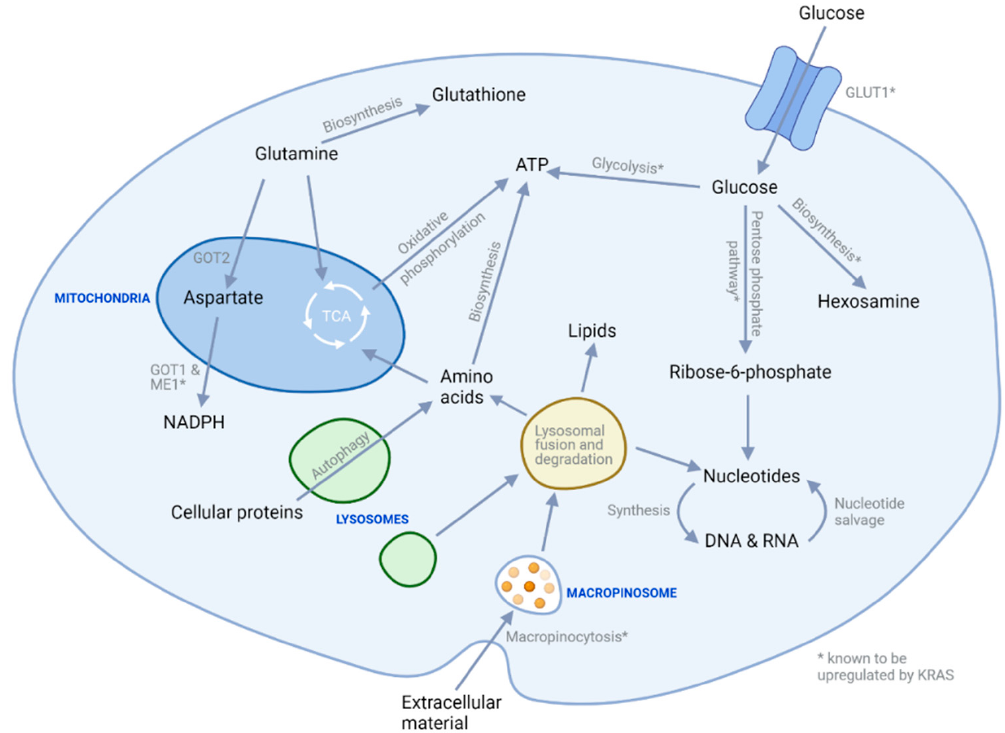
Figure 1. Key metabolic pathways in PDAC cells. Glucose, the intracellular abundance of which is increased by Kras- mediated GLUT1 upregulation, is a key metabolic and biosynthetic fuel usually oxidised in the mitochondria to produce ATP. However, while some mitochondrial oxidation of glucose does occur in cancer cells, proportionally higher levels are diverted from this pathway to be utilised in biosynthetic reactions to produce hexosamine (used in protein glycosylation) and ribose-6-phosphate (used in nucleotide synthesis). Cancer cells also show a greater dependency on glycolytic ATP generation with upregulation of this pathway in PDAC mediated both by oncogenic signalling via the Kras pathway and hypoxic conditions resulting from hypovascularity. Cancer cells also demonstrate an enhanced use of glutamine, which is vital in cellular proliferation due to its use in ATP generation and the production of NADPH and glutathione to maintain cellular redox balance. Nutrient deprivation in PDAC due to hypovascularity also alters cellular metabolism, evoking a requirement for alternative nutrient sources to be found. These include recycling of cellular components through autophagy and nucleotide salvage, as well as scavenging pathways such as macropinocytosis in which large vacuoles non-specifically engulf extracellular space to obtain proteins, lipids, and